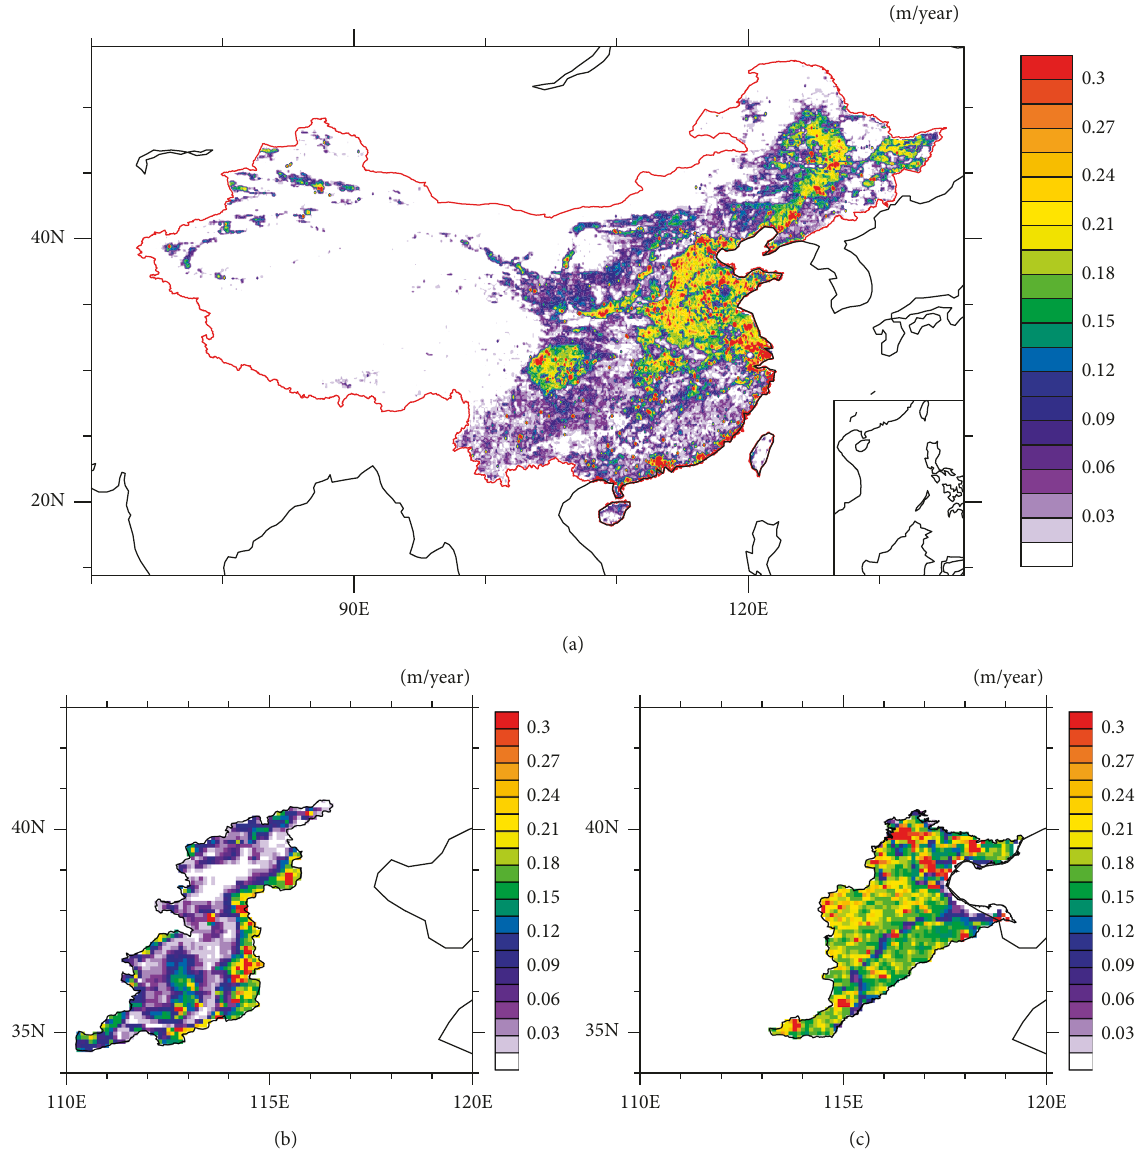
Figure 3: Spatial distributions of estimated water demand per unit area in 2000 over (a) all of China, (b) the Taihang Mountains, and (c) Haihe Plain. Table 1: Estimated water demands and actual statistical values in 2000 (unit: 10 8 m 3